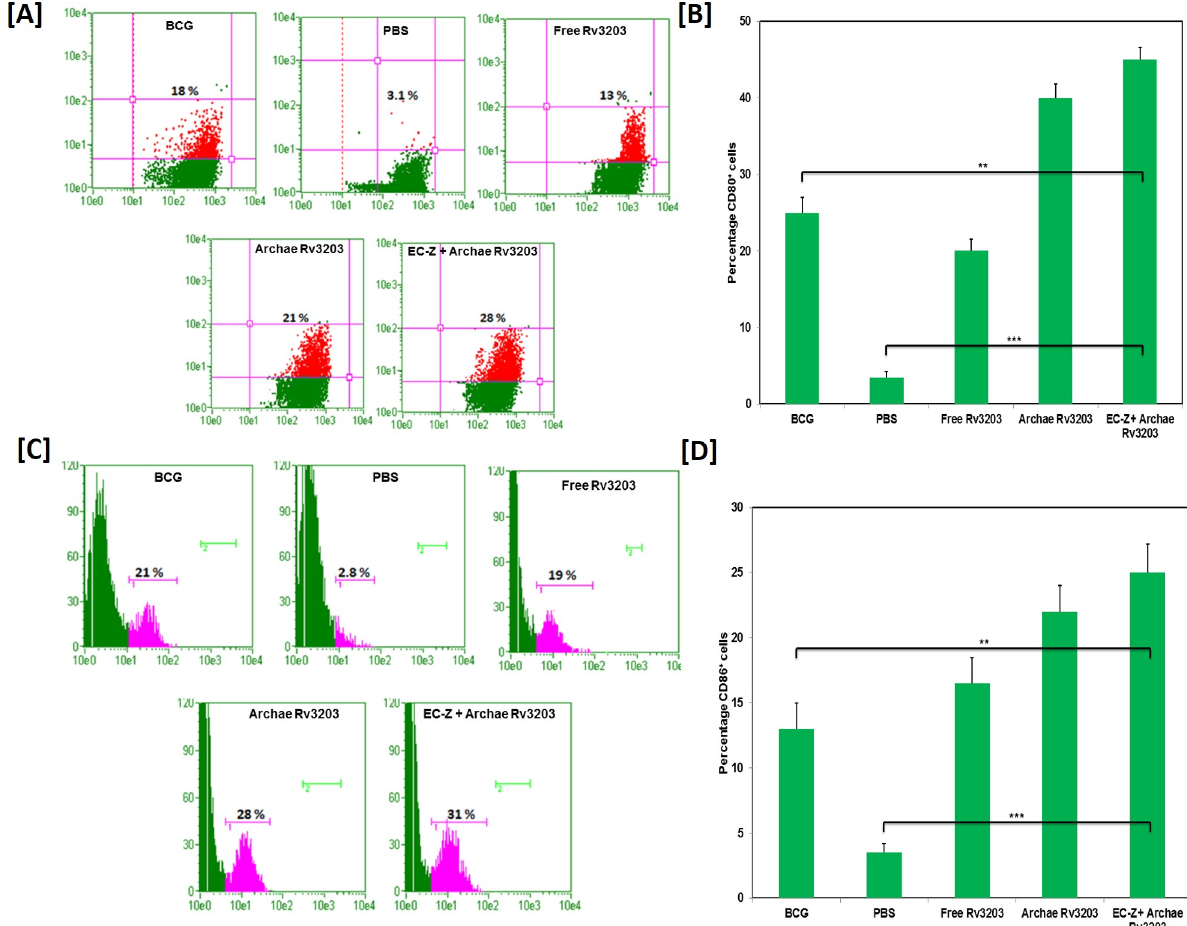
Fig 3. Archaeosome encapsulated Rv3203 up regulates expression of co-stimulatory molecules CD80 + and CD86 + on antigen presenting cells. The target cells were analysed for presence of CD80+/CD86 + marker on their surface using flow cytometry (A)& (C) respectively. While (B) and (D) respectively represented the bar form of the expression of CD80+/CD86 + molecules on the surface of target cells. Statistical significance was determined as described in materials and methods. p (cid:1) 0.05, p < 0.01, p < 0.001 and p > 0.05 represented as ( * ), ( ** ), ( *** ) and (NS) respectively.